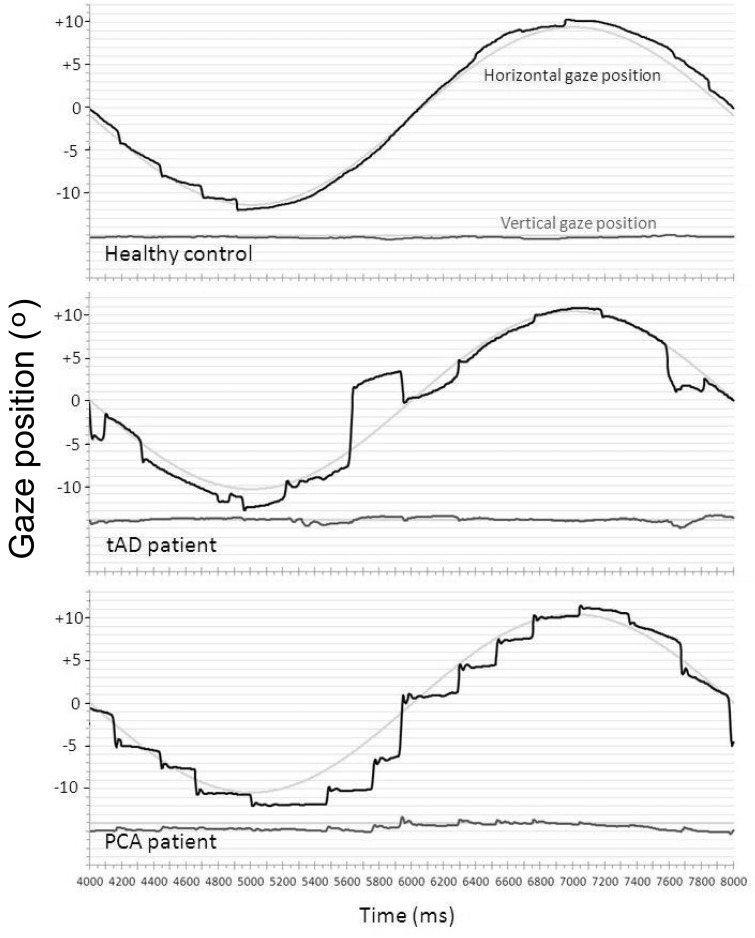
Example traces from the pursuit task for a healthy control, a patient with typical Alzheimer’s disease and a PCA patient. The figure shows a cycle towards the middle of the trial (seconds 4–8 from a trial of 10 s). Positive values of gaze position indicate rightward gaze. The upper plot (grey line) for each participant shows gaze position in the y (vertical) axis, the lower plot (black line) shows gaze position in the x (horizontal) axis. Target position is represented by a faint blue line. Gridlines show displacement of 1° of visual angle. tAD = typical Alzheimer’s disease.